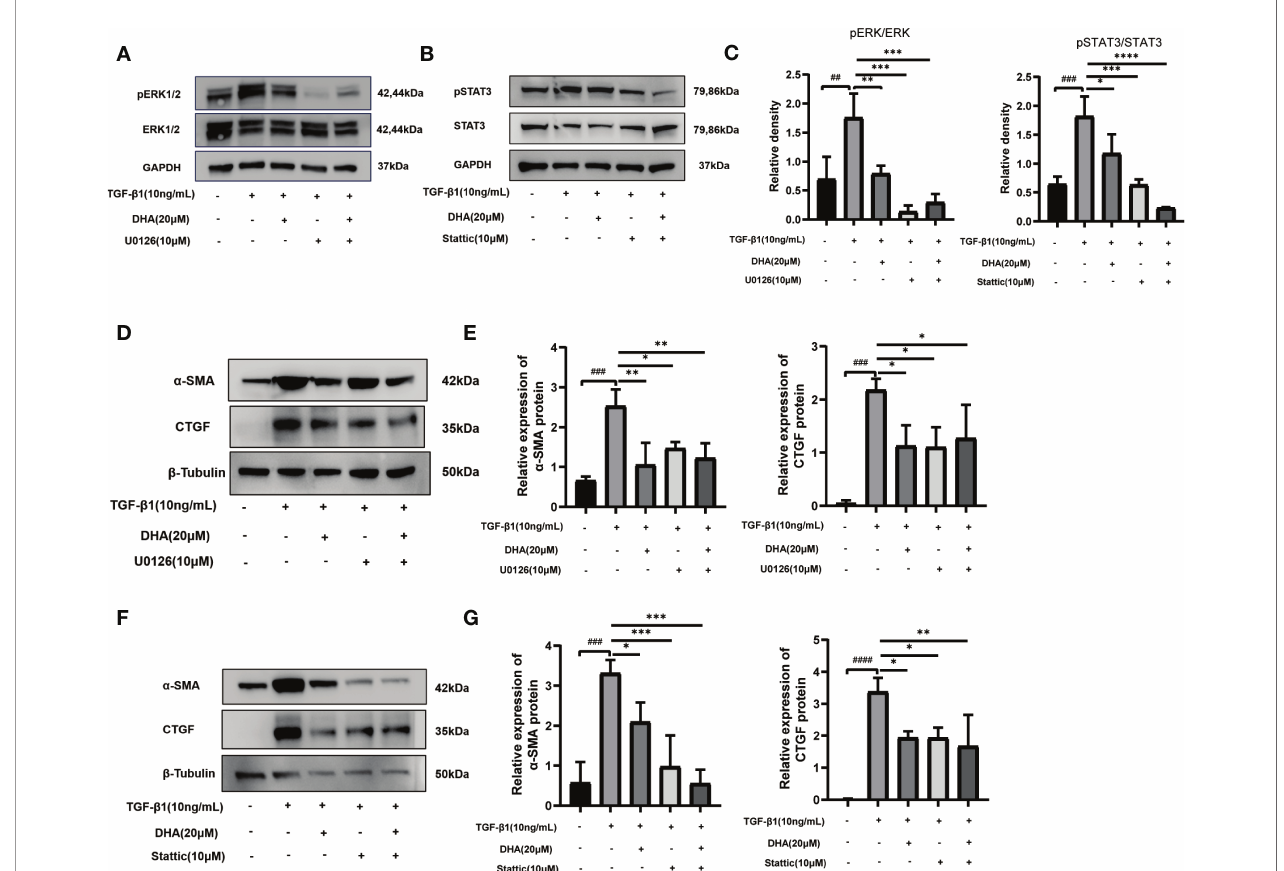
FIGURE 5 | DHA exerts an anti fi brotic effect on GO-derived OFs by repressing activation of the MAPK/ERK and STAT3 signaling pathways. (A, B) GO-derived OFs were stimulated with TGF- b 1 (10 ng/mL, 3 h) with or without a 3-h pretreatment with DHA (20 m M) or ERK inhibitor U0126 (10 m M) or STAT3 inhibitor Stattic (10 m M). The expression and phosphorylation levels of ERK1/2 and STAT3 were determined using western blot analysis (n = 3). (C) The protein levels of pERK1/2 and pSTAT3 were quanti fi ed and analyzed. (D) GO-derived OFs were stimulated with TGF- b 1 (10 ng/mL, 48 h) with or without a 3-h pretreatment with DHA (20 m M) or ERK inhibitor U0126 (10 m M). The expression levels of a -SMA and CTGF were determined using western blot analysis (n = 3). (E) The protein levels of a -SMA and CTGF were quanti fi ed and analyzed. (F) GO-derived OFs were stimulated with TGF- b 1 (10 ng/mL,48 h) with or without a 3-h pretreatment with DHA (20 m M) or STAT3 inhibitor Stattic (10 m M). The expression levels of a -SMA and CTGF were determined using western blot analysis (n = 3). (G) The protein levels of a -SMA and CTGF were quanti fi ed and analyzed. For (C, E, G) , the summarized data are reported as the mean ± standard error of the mean. ## P < 0.01, ### P < 0.001, #### P < 0.0001 compared with the control; *P < 0.05, **P < 0.01, ***P < 0.001, ****P < 0.0001 compared with TGF- b 1